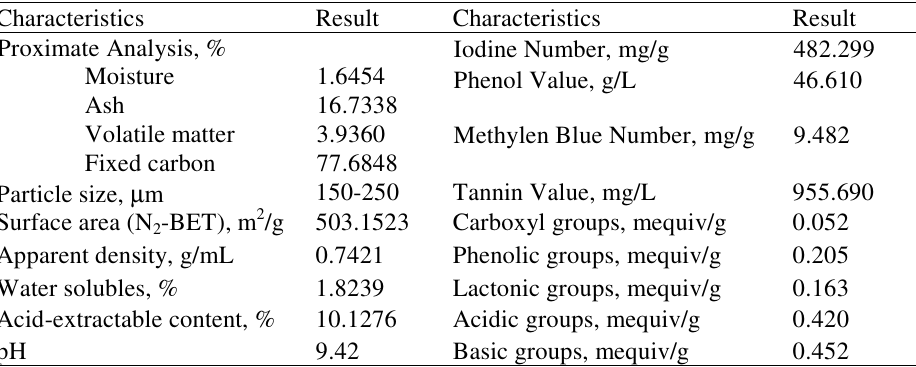
Table 1. Characteristics of Activated